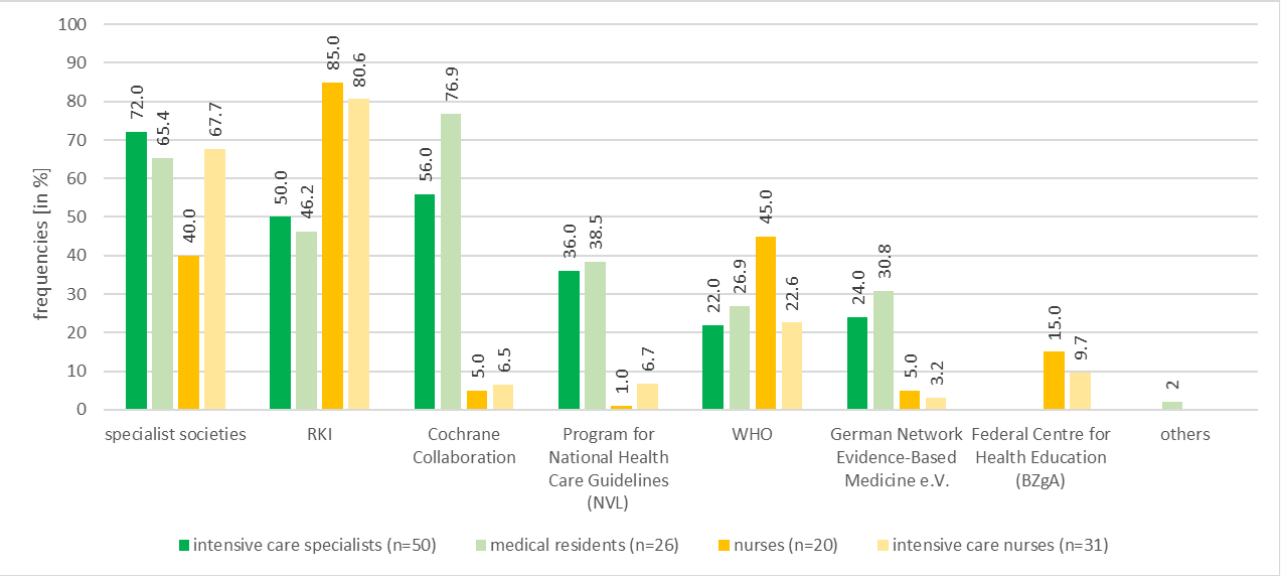
Figure 2. Trust in organizations according to professions 2021. RKI Robert Koch Institute, WHO World health organization.